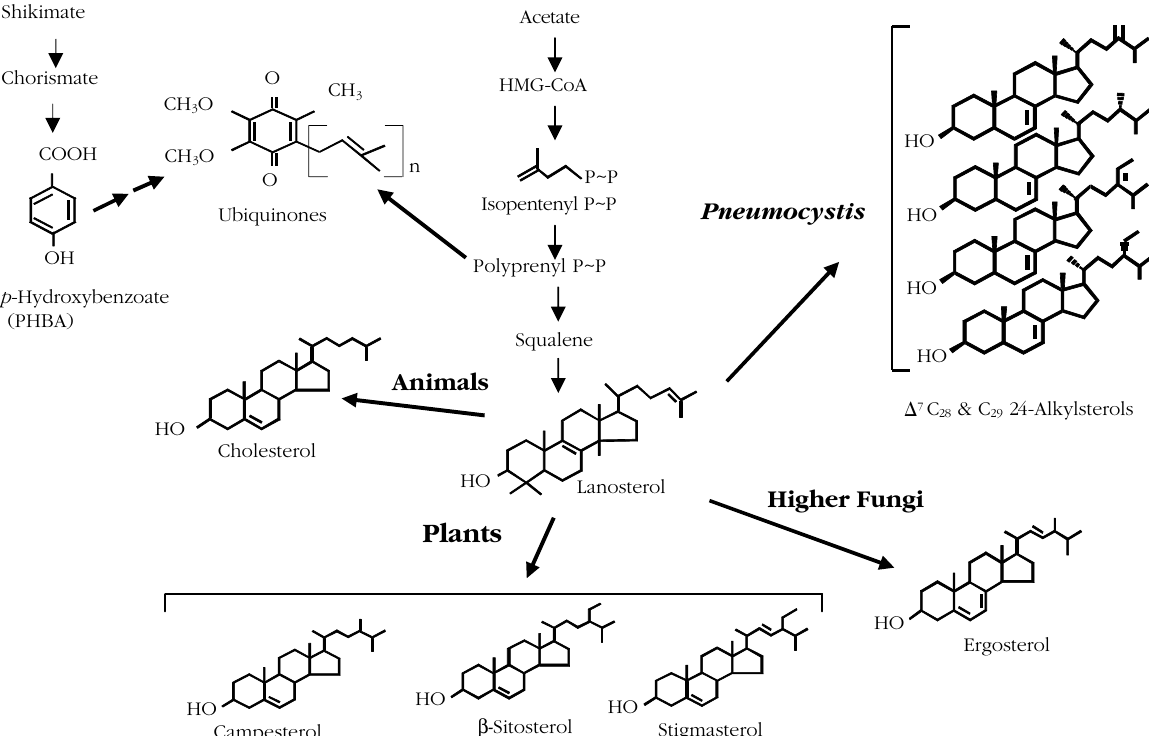
Fig. 2. – Generalized scheme of the classical acetate to 3-hydroxy-3-methyl-glutaryl-Coenzyme a (hMG-Coa) isoprenoid pathway leading to polyprenyl diphosphates. These long chain molecules are utilized in sterol biosynthesis in eukaryotes. Polyprenyl diphosphates are also transferred to p -hydroxybenzoate (PhBa) formed via the shikimic acid pathway and chorismate resulting in the formation of ubiquinone homologs (Coenzyme Q,